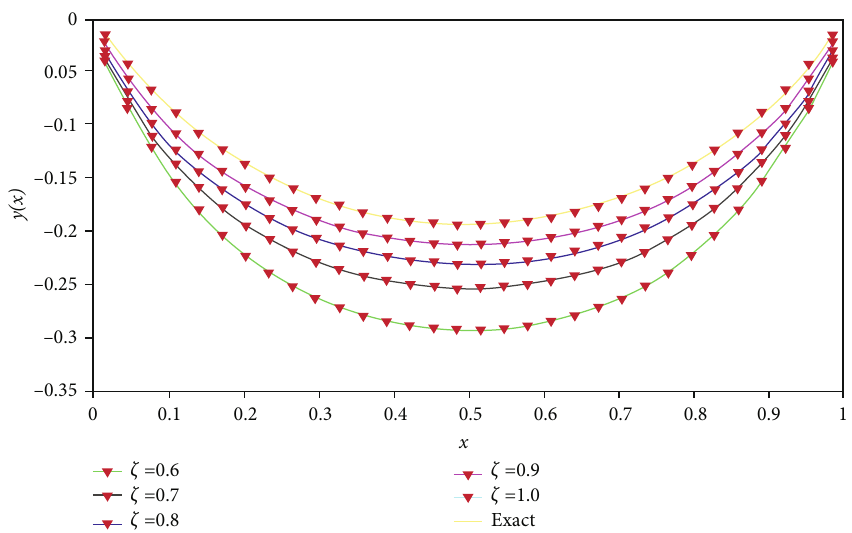
Figure 5: Exact solution for ρ = 1 and numerical solutions for various choices of ρ . Table 6: Comparison of results obtained in [31] and by our method for φ ð ζ Þ = ð ζ 2 /2 Þ + ð ζ /2 Þ